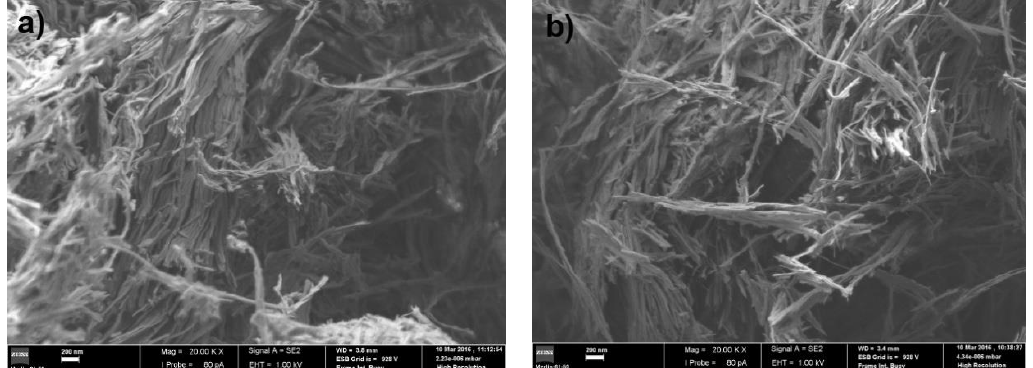
Figure 4. FE-SEM micrographs of the sepiolite samples at 20,000 magnification: ( a ) sepiolite 1; ( b ) sepiolite 2. The scale bars correspond to 200 nm.